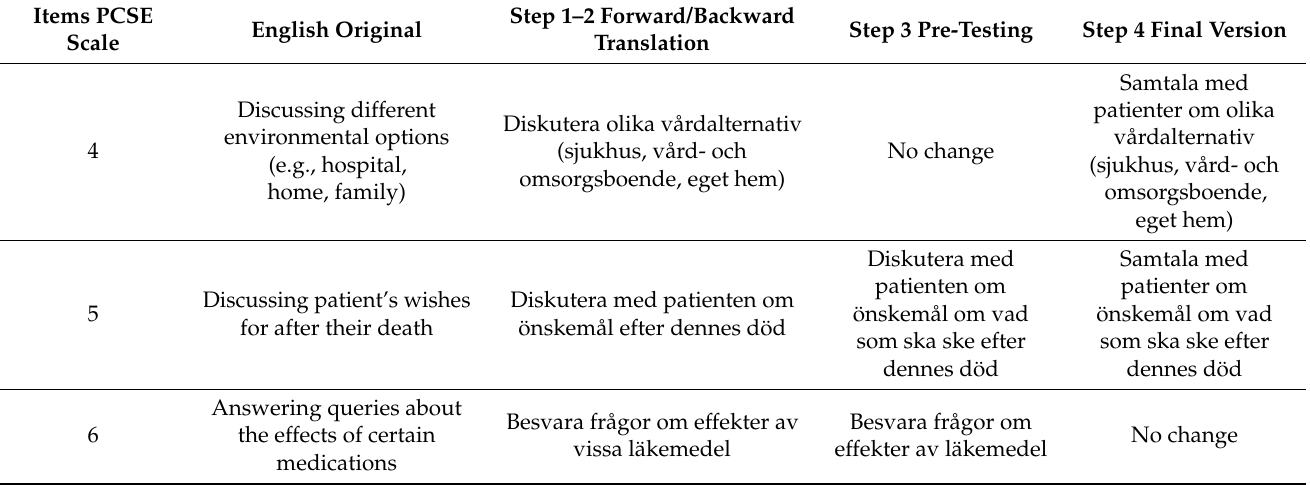
Table 2. English original, step 1–2 forward/backward translation, step 3 pre-testing, and step 4 final